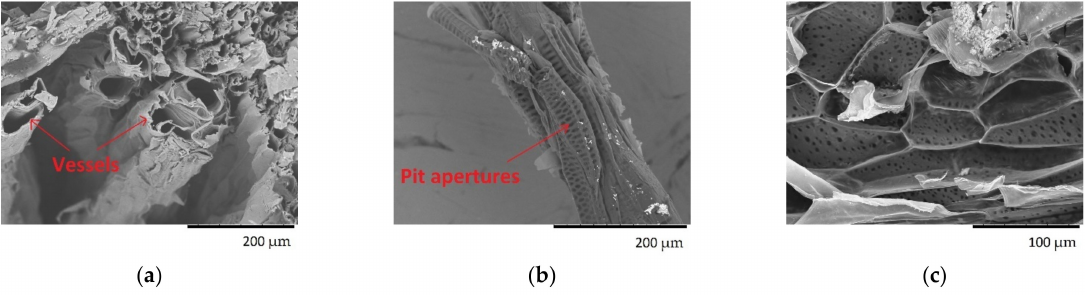
Figure 7. SEM images of Opuntia fibre bundles: ( a ) vessels, ( b ) tracheid with pit apertures, ( c ) periderm